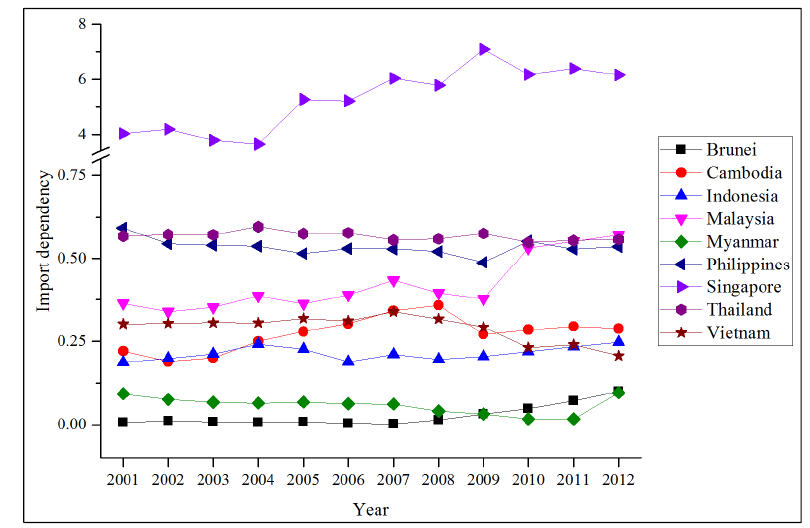
Figure 41. Energy import dependence (by country).